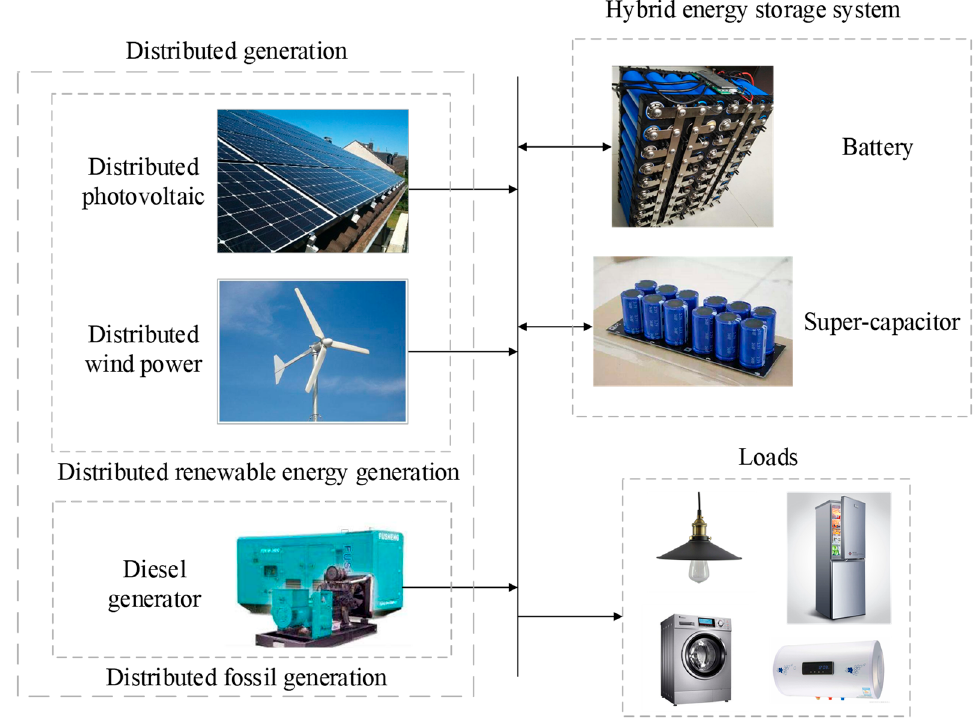
Figure 1. The structure diagram of a distributed power system.